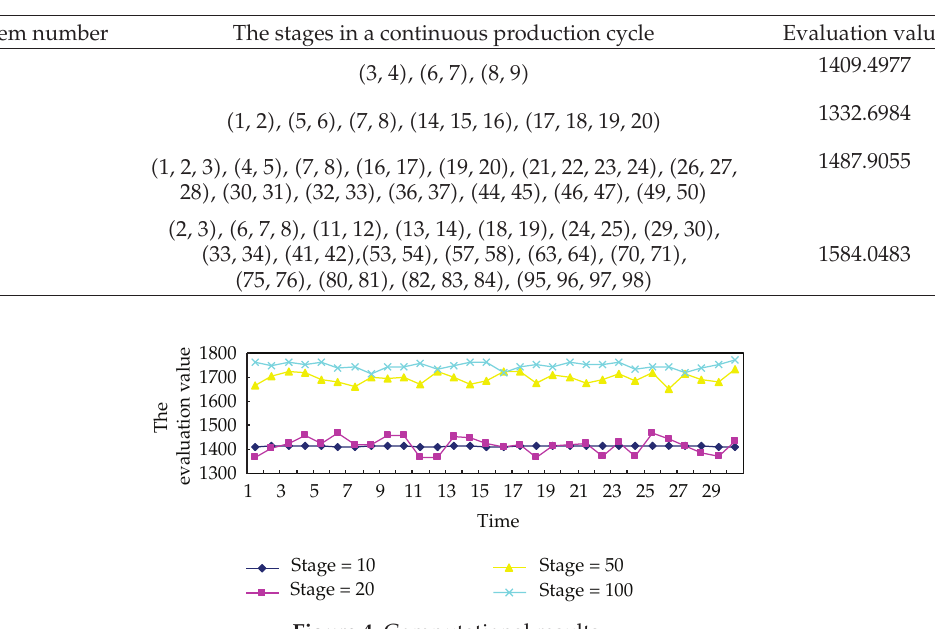
Table 7: The partial best solutions and evaluation values.